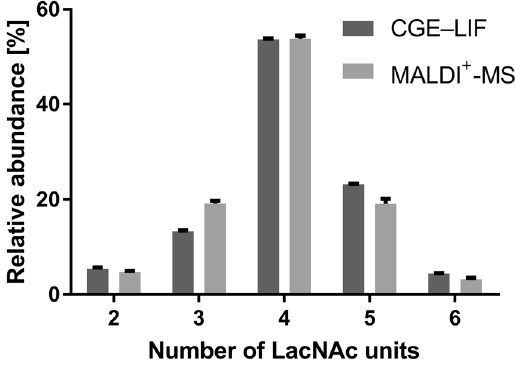
Figure 7. Comparison of the MALDI-TOF-MS glycan profiles to CGE–LIF profiles. Relative abundance data was summed to comparable categories based on the number of LacNAc